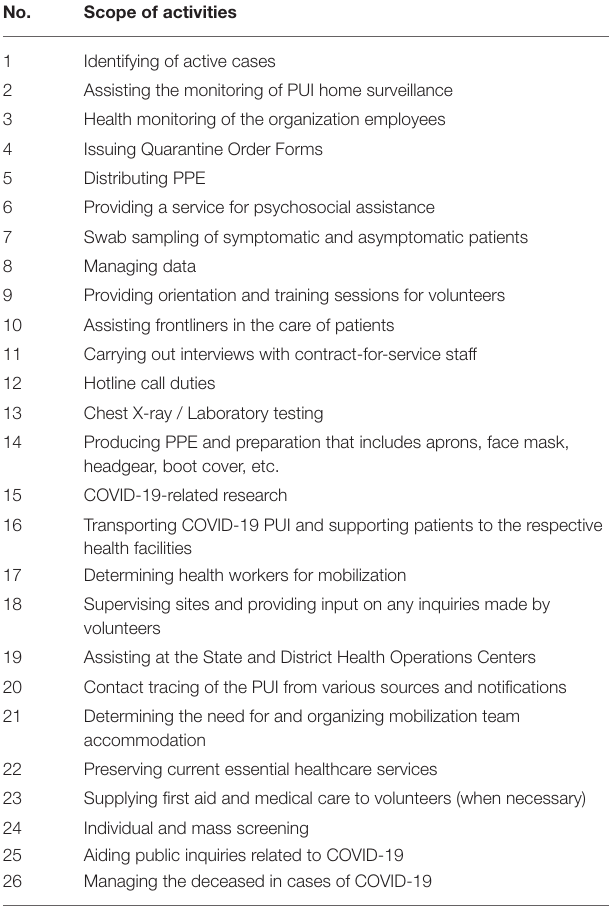
TABLE 1 | Scope of activities for the healthcare personnel during deployment.